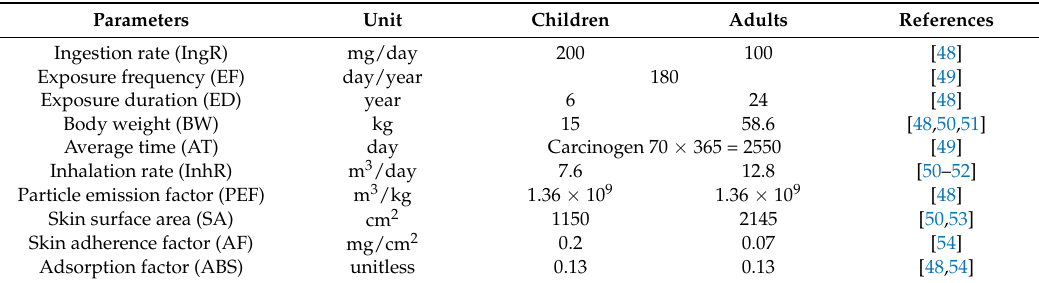
Table 2. Values of parameters used in health risk assessment